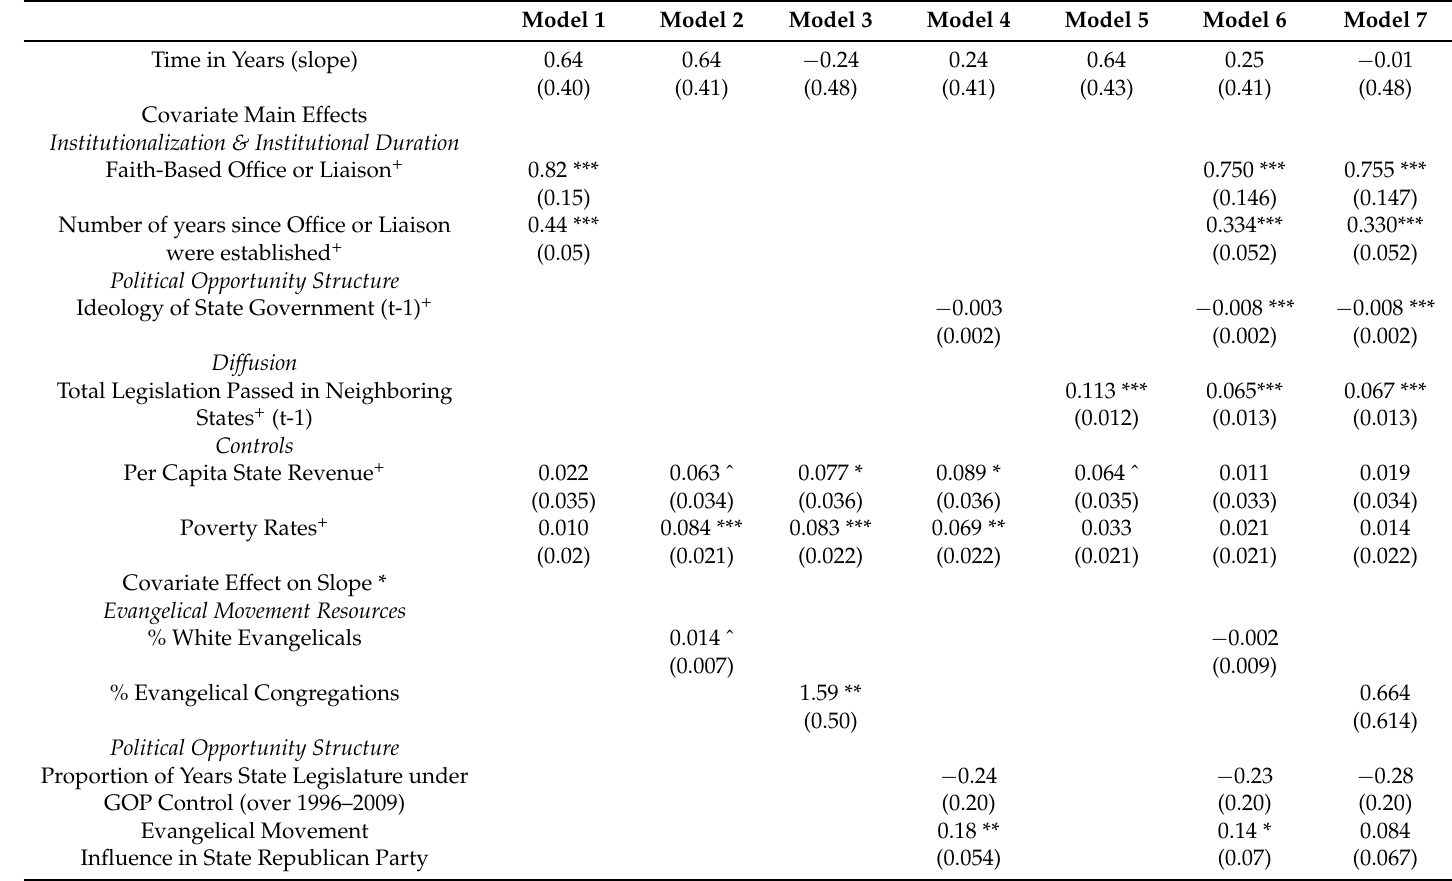
Table 4. MMC Analysis of Cumulative Faith-Based Legislation on State Charateristics: